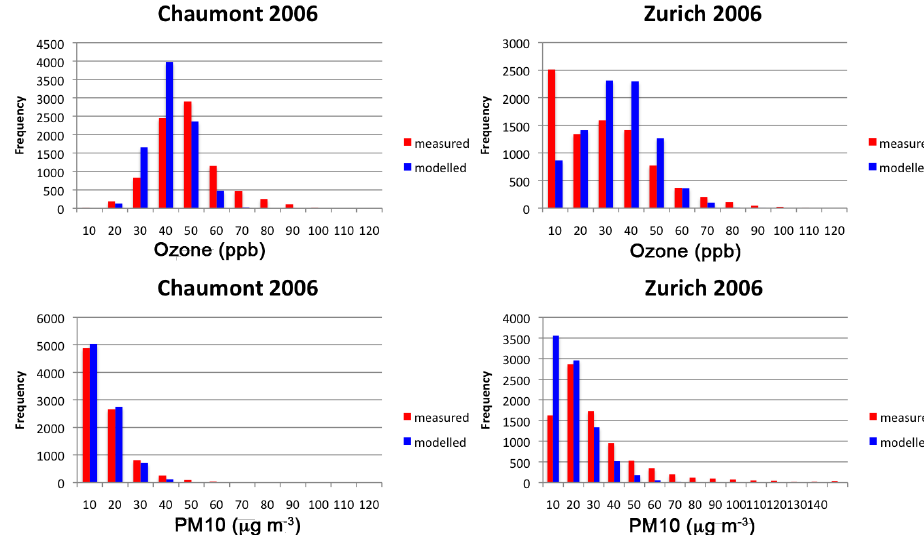
Figure 3. Frequency distributions of ozone (upper panel) and PM 10 (lower panel) at Chaumont (rural) and Zurich (urban background) in 2006.